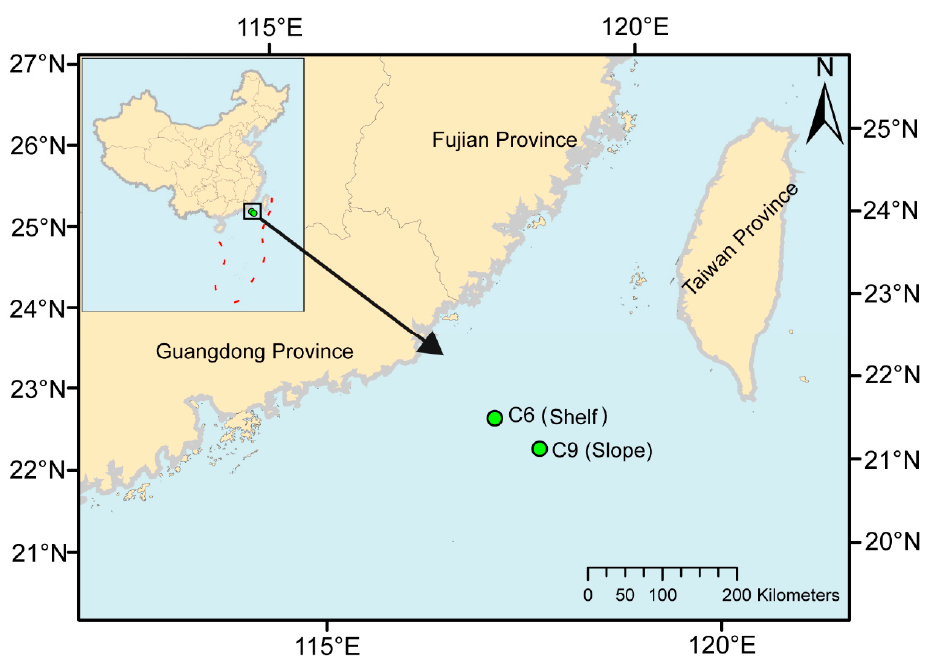
Figure 1. Location of the study area in northern South China Sea map showing the stations sampled. Sampling was carried out at Station C6 (117.46 ◦ E, 22.13 ◦ N) at the surface and DCM, which is on the continental shelf with a depth of 77 m; and Station C9 (117.99 ◦ E, 21.69 ◦ N) at the surface, DCM and Bottom, which is on the continental slope with a depth of 1369 m.